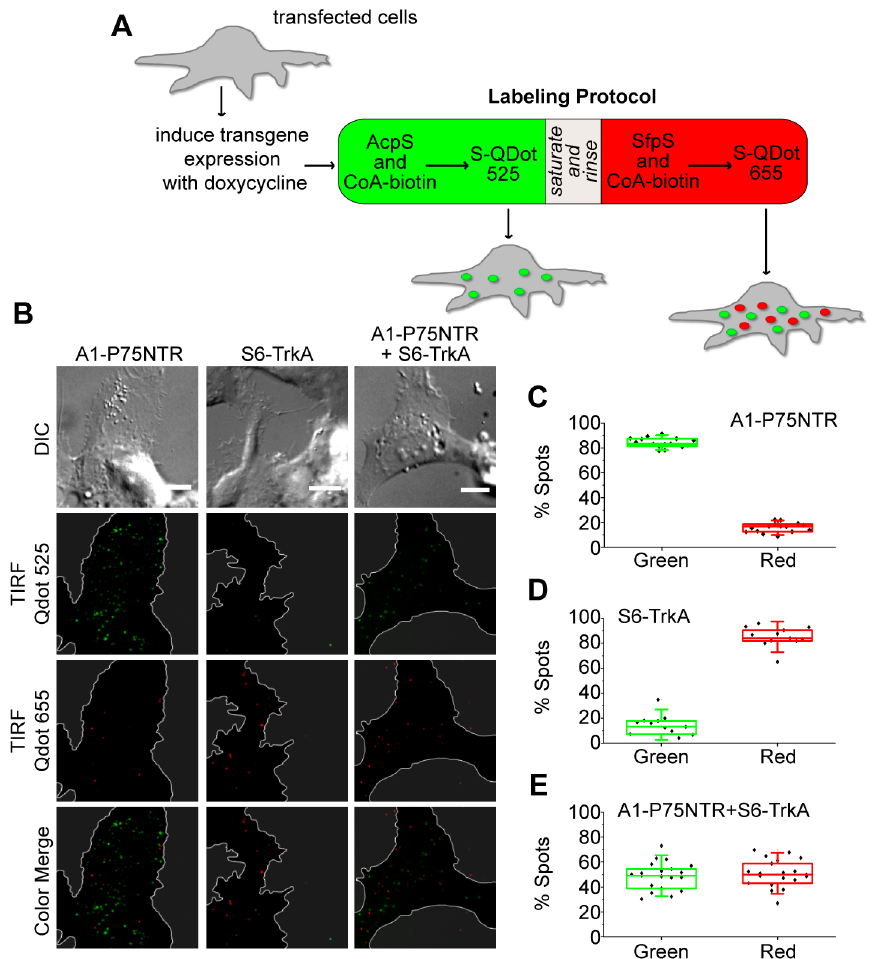
Figure 4. TIRFM detection of PPTase-specific A1-P75NTR and S6-TrkA fluorolabeling. A ) Scheme of the dual-color labeling protocol used in the experiment. Details are provided in Materials and Methods. B ) TIRF microimages analyzing PPTase-specific A1-P75NTR and S6-TrkA fluorolabeling at the SH-SY5Y plasma membrane. A1 labeling by AcpS is detected by S-Qdot525; S6 labeling by SfpS is detected by S-Qdot655. Borders of the cells basal membrane, determined through the DIC image, are highlighted in the corresponding TIRF images by a white line, while areas outside cells are grayed to simplify image interpretation. Scale bars: 10 m m. C–E ) Quantification of the % of green and red over total particles at the basal membrane of each analyzed cell expressing A1-P75NTR ( C ), S6-TrkA ( D ) or both constructs ( E ).